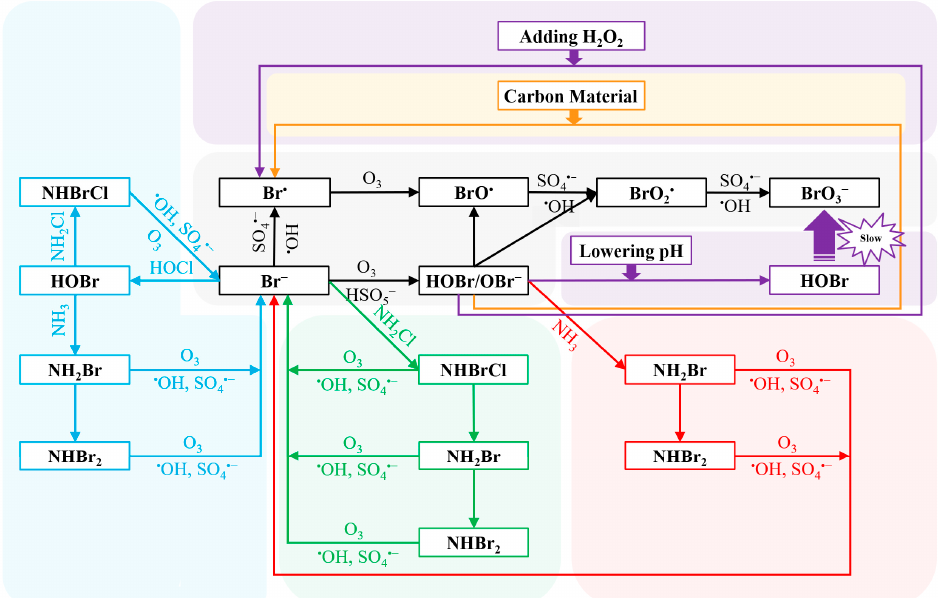
Figure 4. The mechanism of the inhibition of bromate formation (gray: bromate formation; orange: carbon materials; red: NH 3 ; blue: Cl 2 -NH 3 ; green: NH 3 -Cl 2 ; violet: The bromate control strategies that have not been verified in the O 3 /PMS system). Reprinted with permission [64,92,133,134].